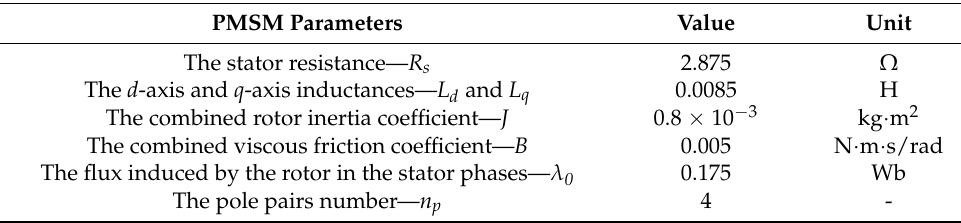
Table 1. The nominal parameters of the